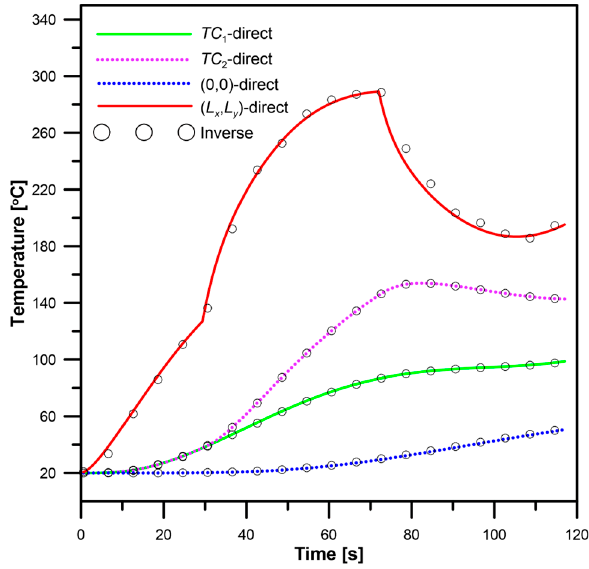
Figure 10. Comparison of “measured” temperature changes in selected points and those calculated by the AMI method for measuring error: σ = 0.05.